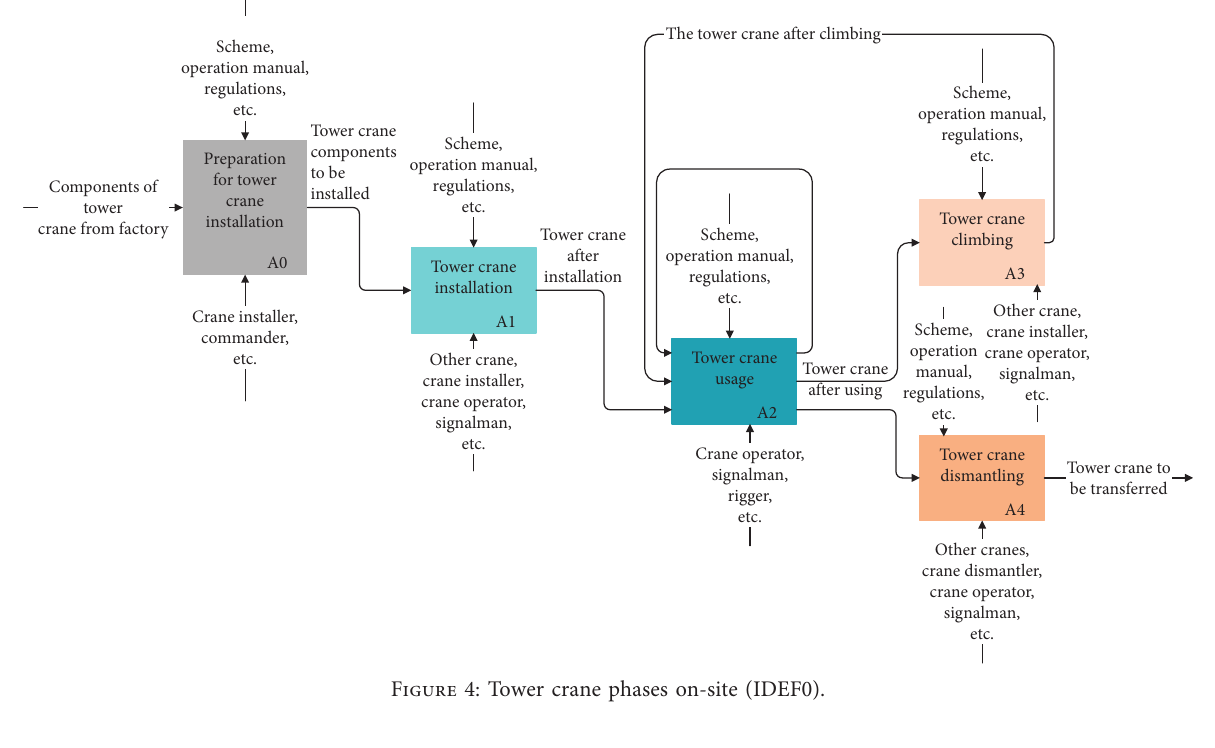
Figure 4: Tower crane phases on-site (IDEF0).